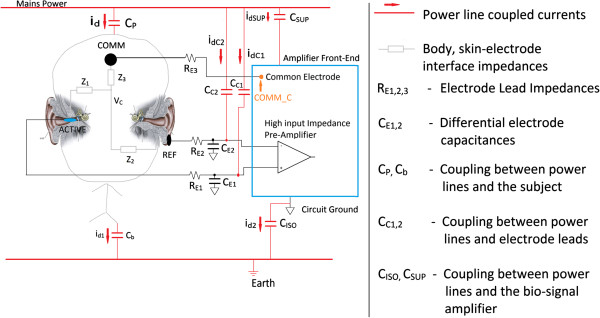
Circuit model for power line interference for ECOG recordings.